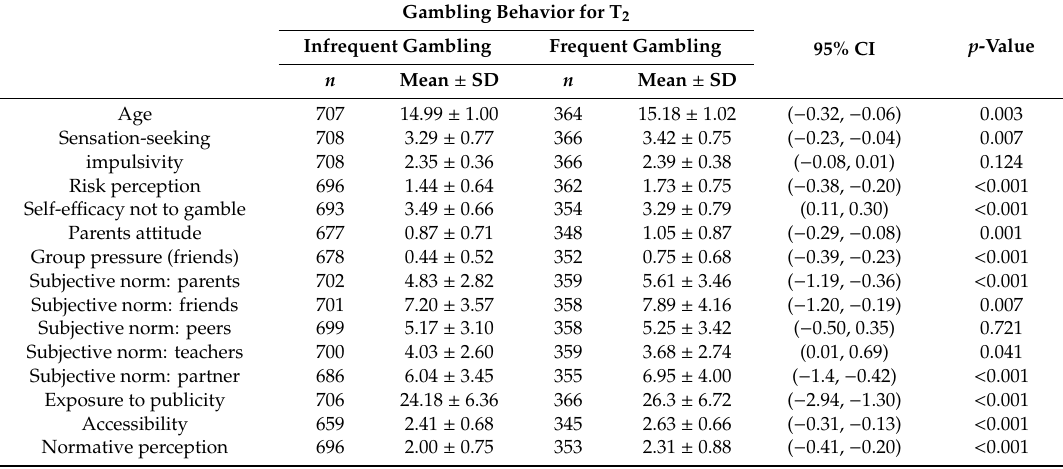
Table 2. Average scores for infrequent gamblers and gamblers and p -value for the t-test of di ff erences between groups.